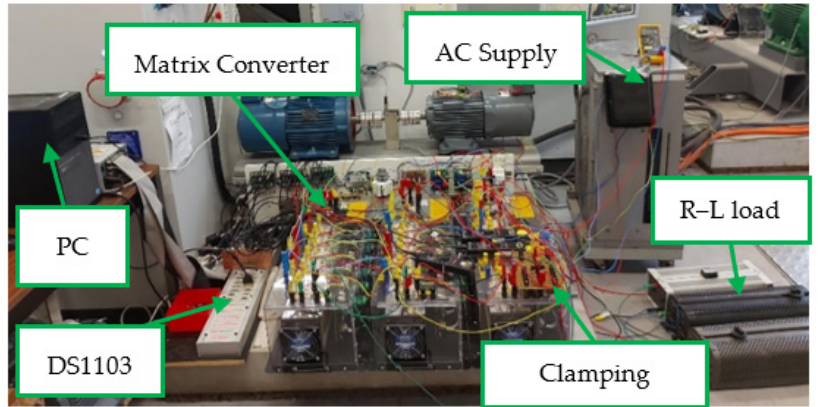
Figure 12. The test bench.